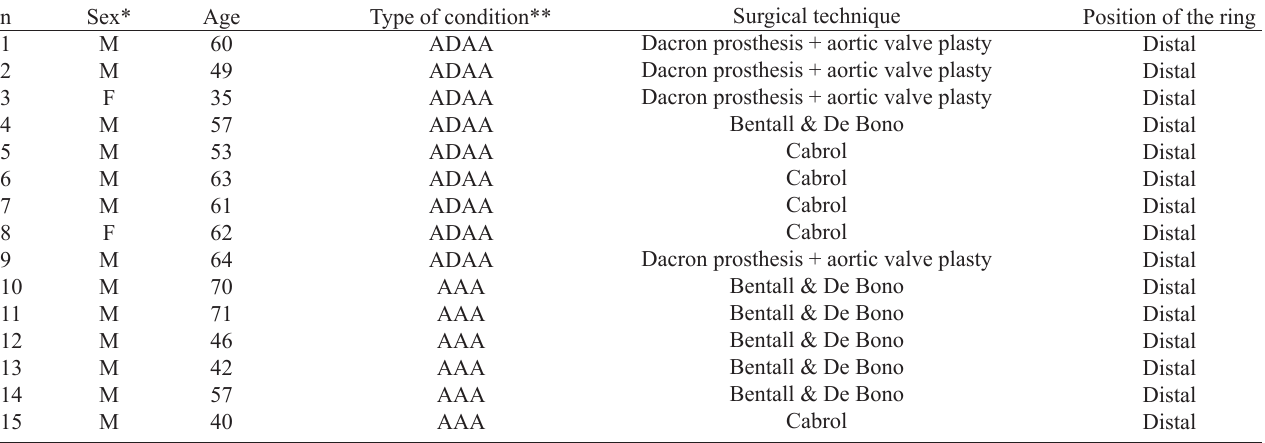
Table 4. Distribution of patients who died and their demographic, diagnostic characteristics and surgical techniques